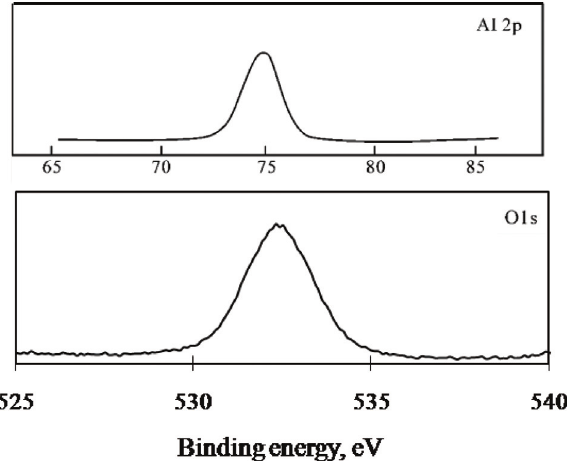
Figure 6: XPS spectra for Al2p and O 1s measured from as exposed substrate surface after removal of top diamond